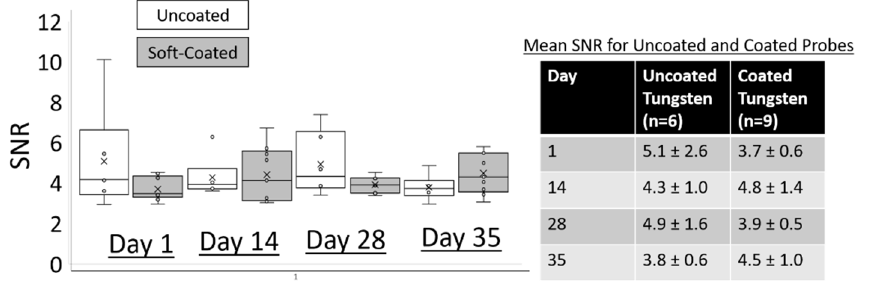
Figure 13. Comparison of SNR for uncoated (white) and coated (gray) tungsten electrodes show similar range of values across post implantation timepoints.